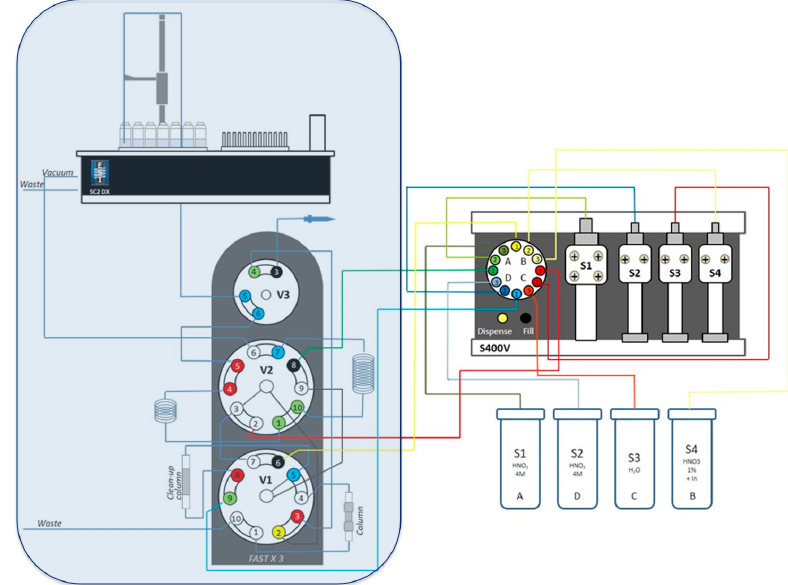
Figure 7. Schematic set-up of the SeaFAST system including the autosampler unit (SC2 DX), the syringe system (S400V), and valve module (FAST DX 3). Blue filled rectangle corresponds to the set-up components placed inside the glove box.